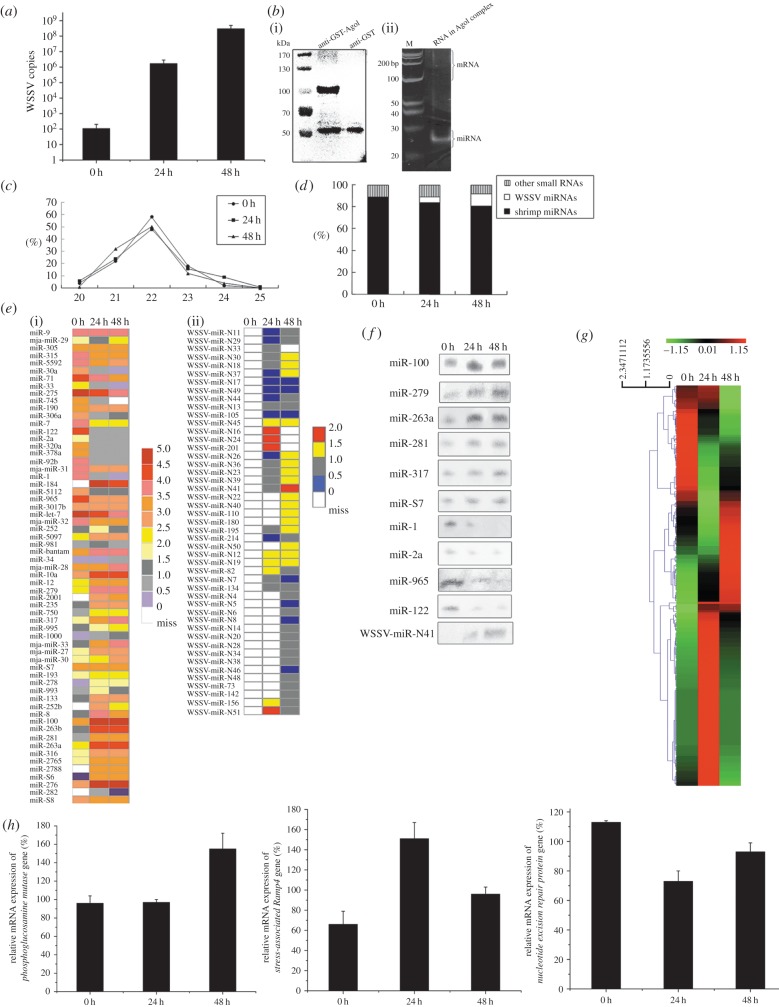
Host and virus miRNAs and mRNAs in the Ago1 complex. (a) The copy number of WSSV genomic DNA in the haemocytes of virus-infected shrimp pre-infection (0), and 24 and 48 h post-infection was quantified using quantitative real-time PCR. (b) The Ago1 complex of virus-infected shrimp haemocytes was co-immunoprecipitated with Ago1-specific antibody. Then the complex was analysed by western blot analysis (i). The anti-GST antibody was used as a control. RNAs in the Ago1 complex were extracted (ii) and subjected to sequencing. M, protein marker or RNA marker. (c) Size distribution of small RNAs in the Ago1 complex pre-infection (0), and 24 and 48 h post-infection. (d) Percentages of sequence reads of shrimp and viral miRNAs in the Ago1 complex of shrimp pre-infection (0), and 24 and 48 h post-infection. (e) The shrimp miRNA (i) and WSSV-miRNA (ii) expression profiles of WSSV-challenged shrimp pre-infection (0), and 24 and 48 h post-infection The numbers on the right indicated the log10 of the number of copies of miRNAs. (f) Northern blots of selected shrimp and WSSV miRNAs. Total RNAs extracted from the Ago1 complexes of virus-free or WSSV-infected shrimp haemocytes were blotted with the DIG-labelled oligodeoxynucleotide probes pre-infection (0), and 24 and 48 h post-infection. (g) Heat map of differentially expressed shrimp and WSSV genes in the Ago1 complex of shrimp haemocytes. The shrimp were infected with WSSV. mRNAs in the Ago1 complex of shrimp haemocytes were sequenced pre-infection (0), and 24 and 48 h post-infection. The colours indicate the Z-values of genes. (h) Real-time PCR detection of gene expression profiles of shrimp in response to WSSV pre-infection (0), and 24 and 48 h post-infection.